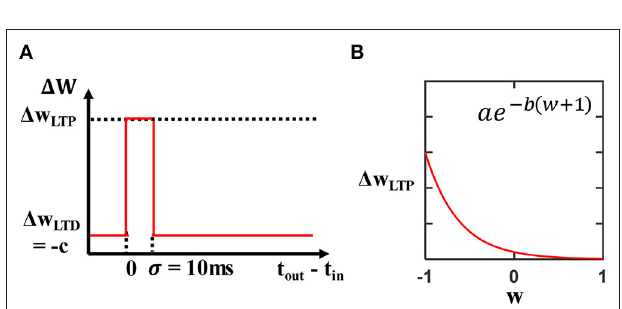
FIGURE 3 | (A) STDP rule showing the 10ms window for an output-input spike time difference ( t out – t in ) that determines whether an LTP or an LTD update is performed. If the output-input spike time difference ( t out – t in ) is within 10ms, the weight corresponding to this input-output synapse is updated via